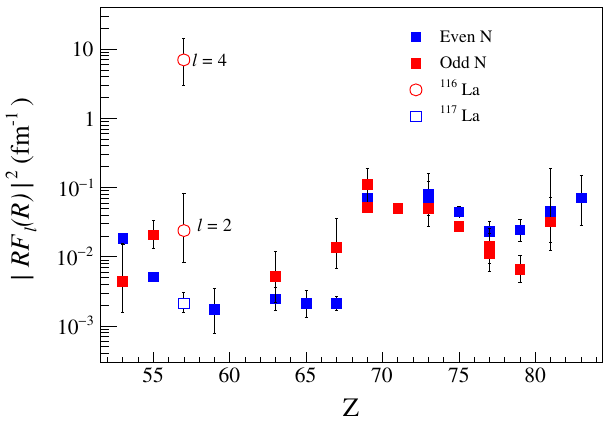
Fig. 3 Proton formation probabilities. These formation probabilities, ∣ RF l ( R ) ∣ 2 , were deduced for the ground-state proton decays in the odd- Z elements between Z = 53 and 83 as a function of the proton number Z . Experimental uncertainties in the half-lives and Q -values have been taken into account in the error bars. The formation probability for 117 La has been calculated using the proton orbital angular momentum l p = 2 ℏ and for 116 La using two alternative values, l p = 2 ℏ and l p = 4 ℏ . Detailed information on the values of l p , Q p and half-lives used for the calculation as well as the derived formation probabilities for all displayed proton-emitters are summarized in Table